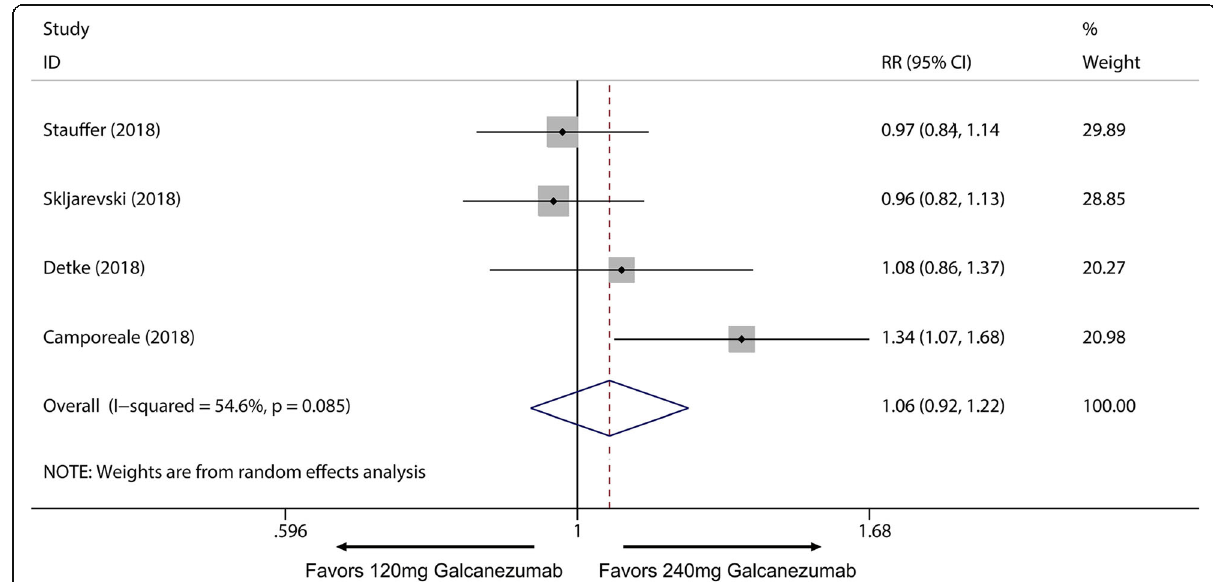
Fig. 5 Comparison of 50% response rate between 120 mg and 240 mg galcanezumab. RR relative risk